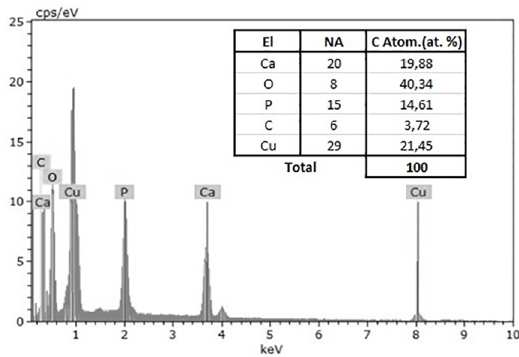
Figure 4. EDS spectrum of the calcium phosphate powder.